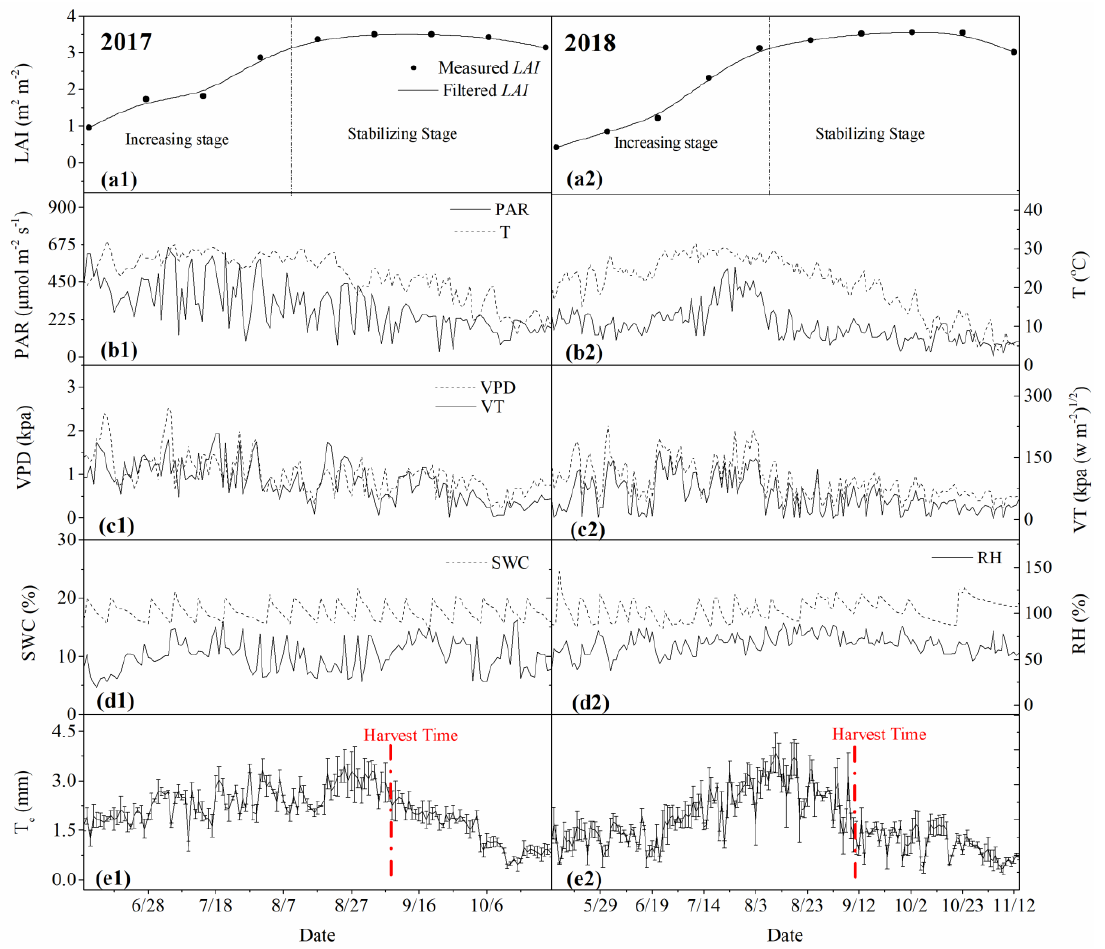
Figure 2. Plots of temporal dynamics of leaf area index (LAI), photosynthetically active radiation (PAR), air temperature (T), vapor pressure deficit (VPD), variable of transpiration (VT), soil water content (SWC), relative humidity (RH) and daily transpiration (T c ) during the experimental period in 2017 ( a1 , b1 , c1 , d1 , e1 ) and 2018 ( a2 , b2 , c2 , d2 , e2 ).